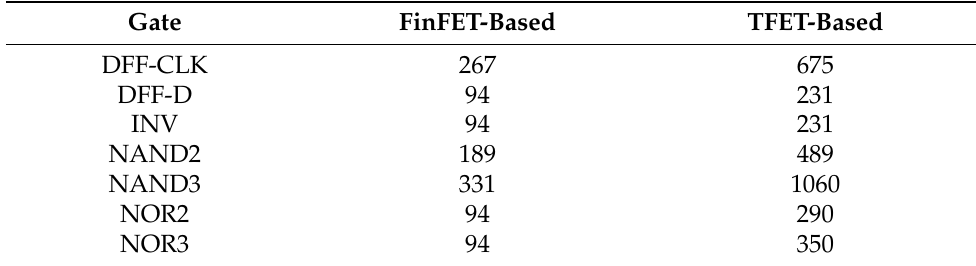
Table 4. Input capacitance